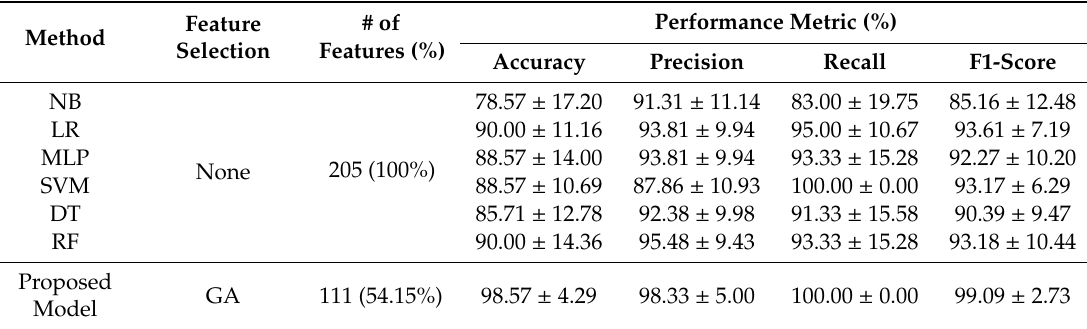
Table 8. Performance comparison of several classification models for dataset II